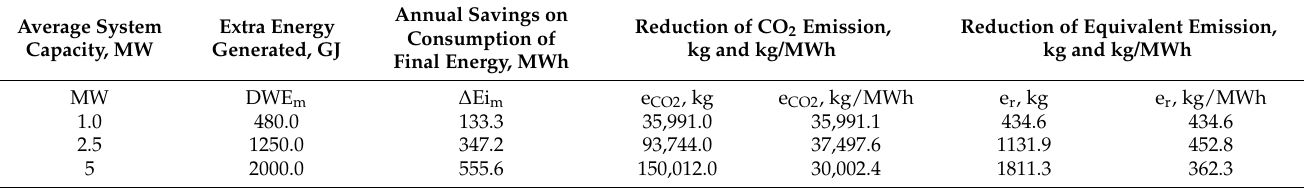
Table 6. The ecological effect as a reduction of the emission of CO 2 and equivalent emission due to the